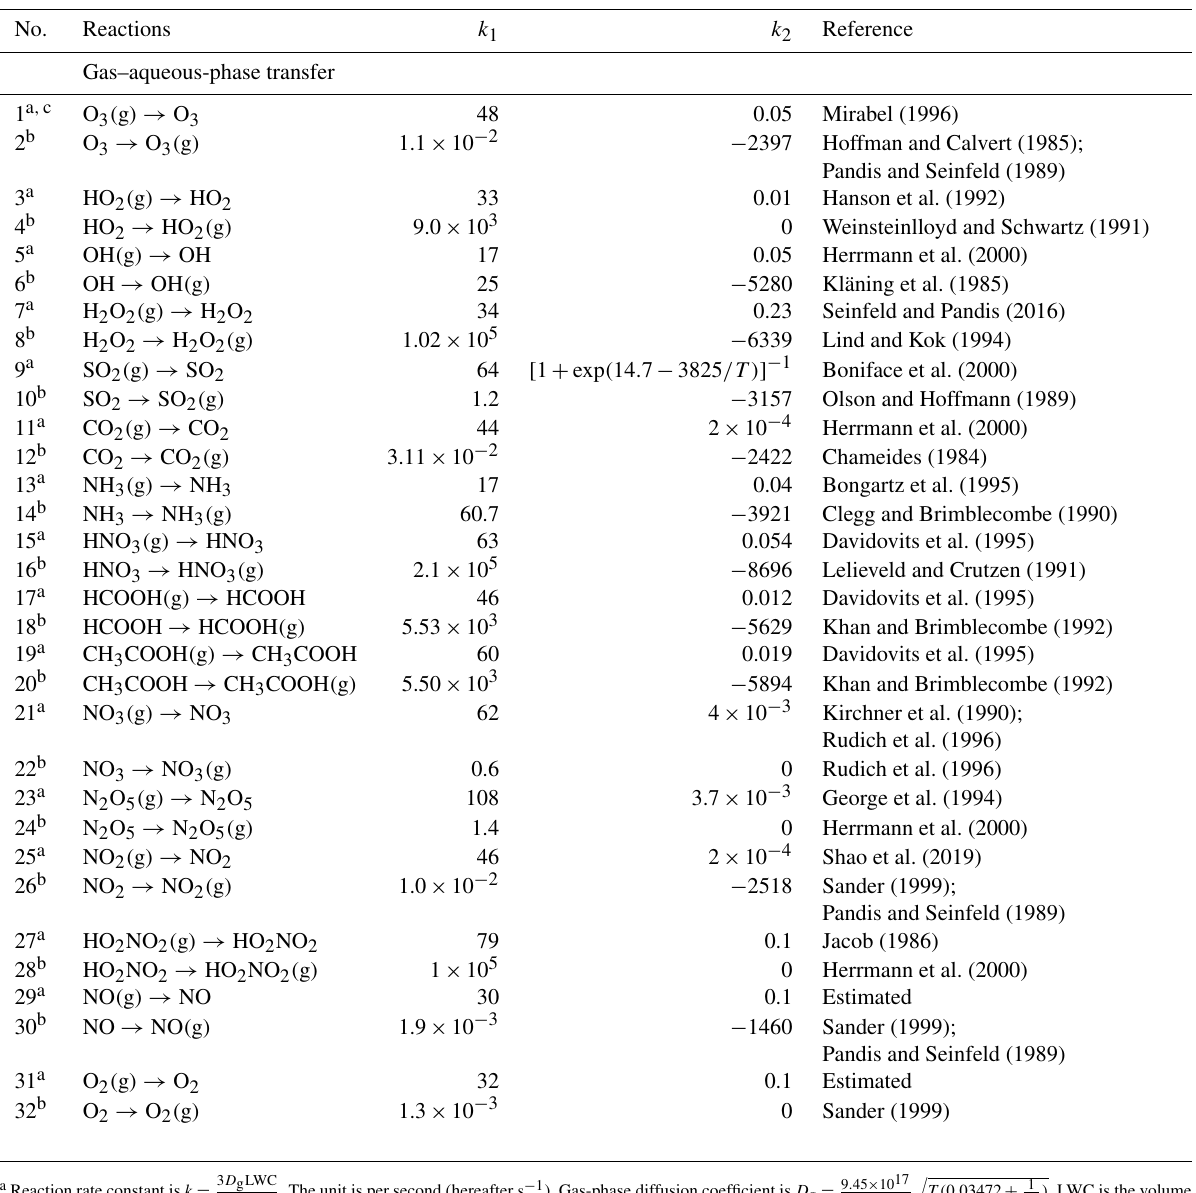
Table 1. Gas–aqueous-phase transfer equilibria. (b) Aqueous-phase chemistry.